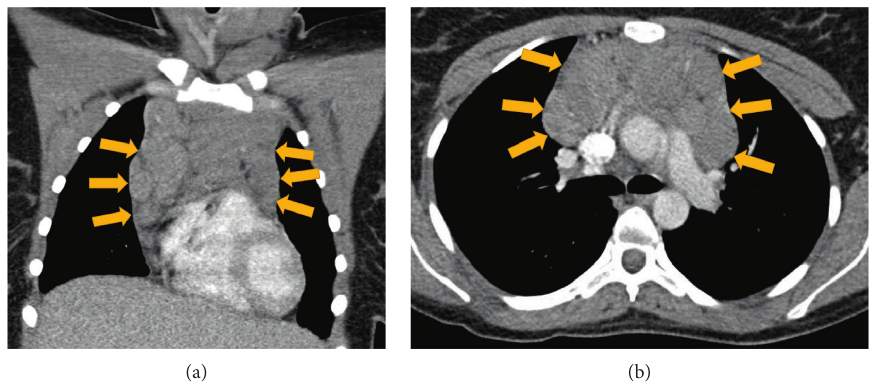
Figure 1: CT thorax demonstrating multiple pathologically enlarged left supraclavicular lymph nodes associated with enlarged partially visualized left cervical lymph nodes. Mass effect on the left lobe of the thyroid gland and the trachea from the pathologically enlarged left supraclavicular lymph nodes. Pathologically enlarged lymph nodes throughout the anterior mediastinum. Enlarged right paratracheal lymph nodes as well. Pathologically enlarged left axillary and subpectoral lymph nodes as